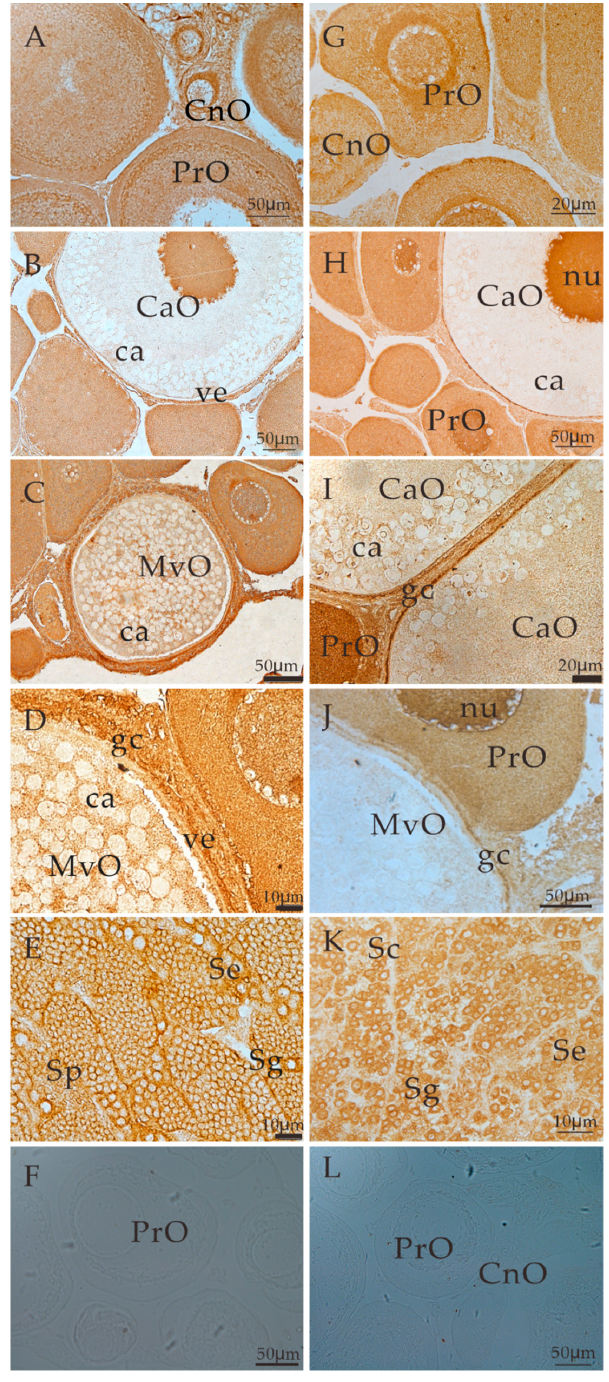
Figure 4. Localization of ALK5 ( A – F ) and BMPR2 ( G – L ) in the ovary and testis of S. prenanti . The sections of the ovary at the primary growth stage ( A ), the previtellogenic stage ( C ), and the mid- to the late-vitellogenic stage ( D ), and of the testis ( E , K ) were immunostained with anti-ALK5 ( A – E ) and BMPR2 ( G – K ) antiserum. Panel F and L: the ovary section immunostained with no antiserum. CnO, chromatin nucleolar oocytes; PrO, perinucleolar oocytes; CaO, cortical alveoli oocytes; MvO, mid-vitellogenic oocytes; nu, nucleolus; ve, vitelline envelope; ca, cortical alveoli; Sg, spermatogonia; Sp, spermatid; gc, granulosa cells; Se, Sertoli cells.